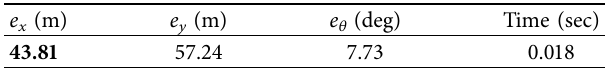
Figure 6: The induced estimation error for the EKF (one land- mark-non-Gaussian noise). Table 3: The mean value of numerical readings of the EKF with one landmark and non-Gaussian